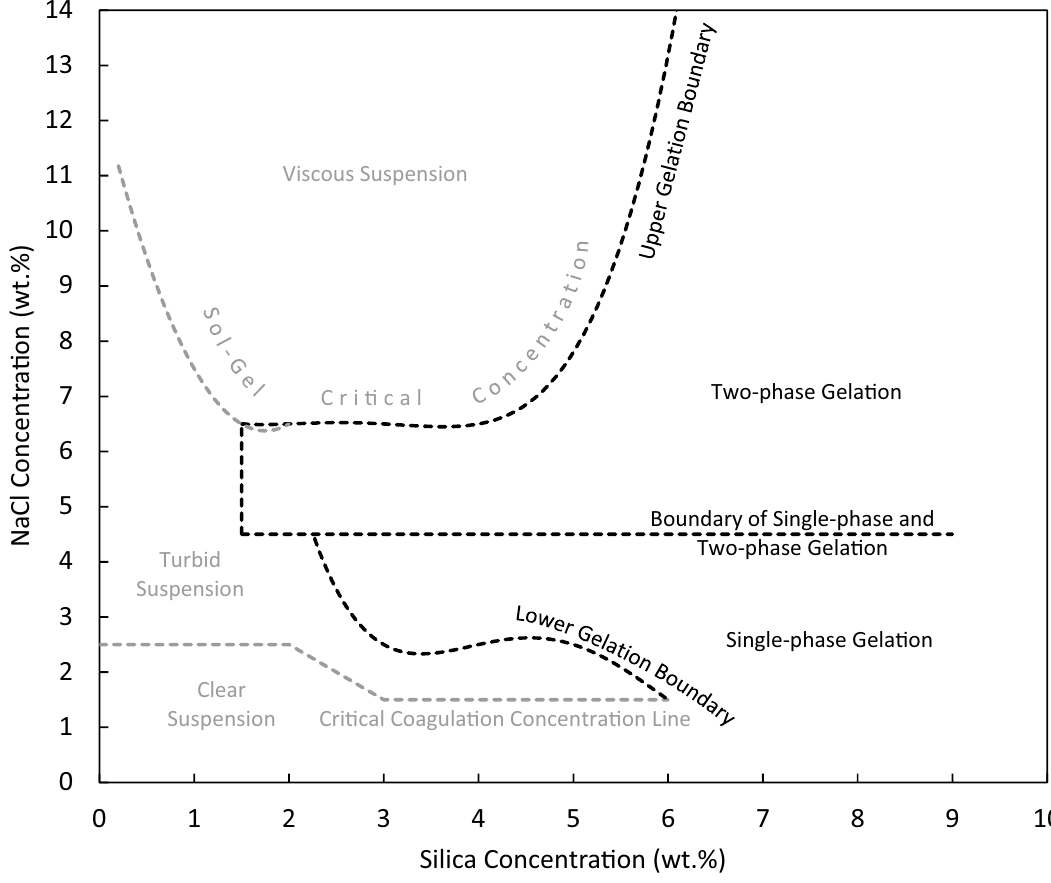
Figure 2. General map of bottle test results based on the experimental observations in bottle tests. The curves and lines are fits to the